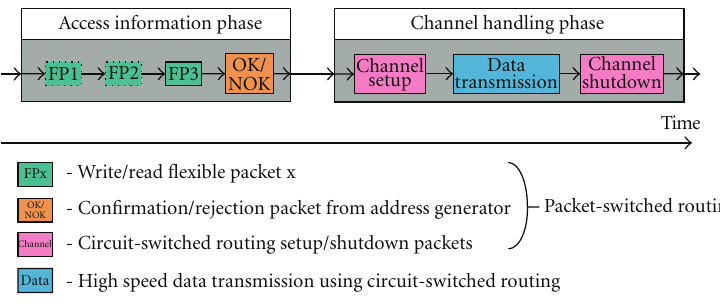
Figure 5: Memory access protocol.